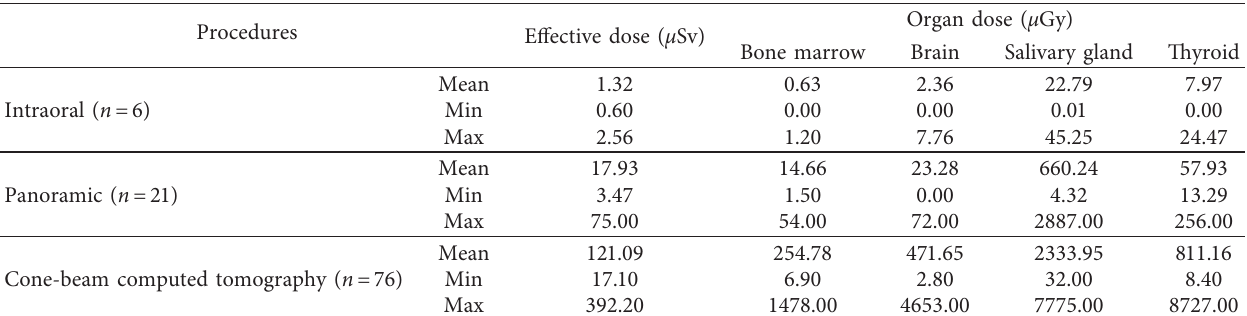
Table 5: Minimum, mean, and maximum values of effective and organ (bone marrow, brain, salivary gland, and thyroid) doses from intraoral, panoramic, and cone-beam computed tomography procedures reported in the selected